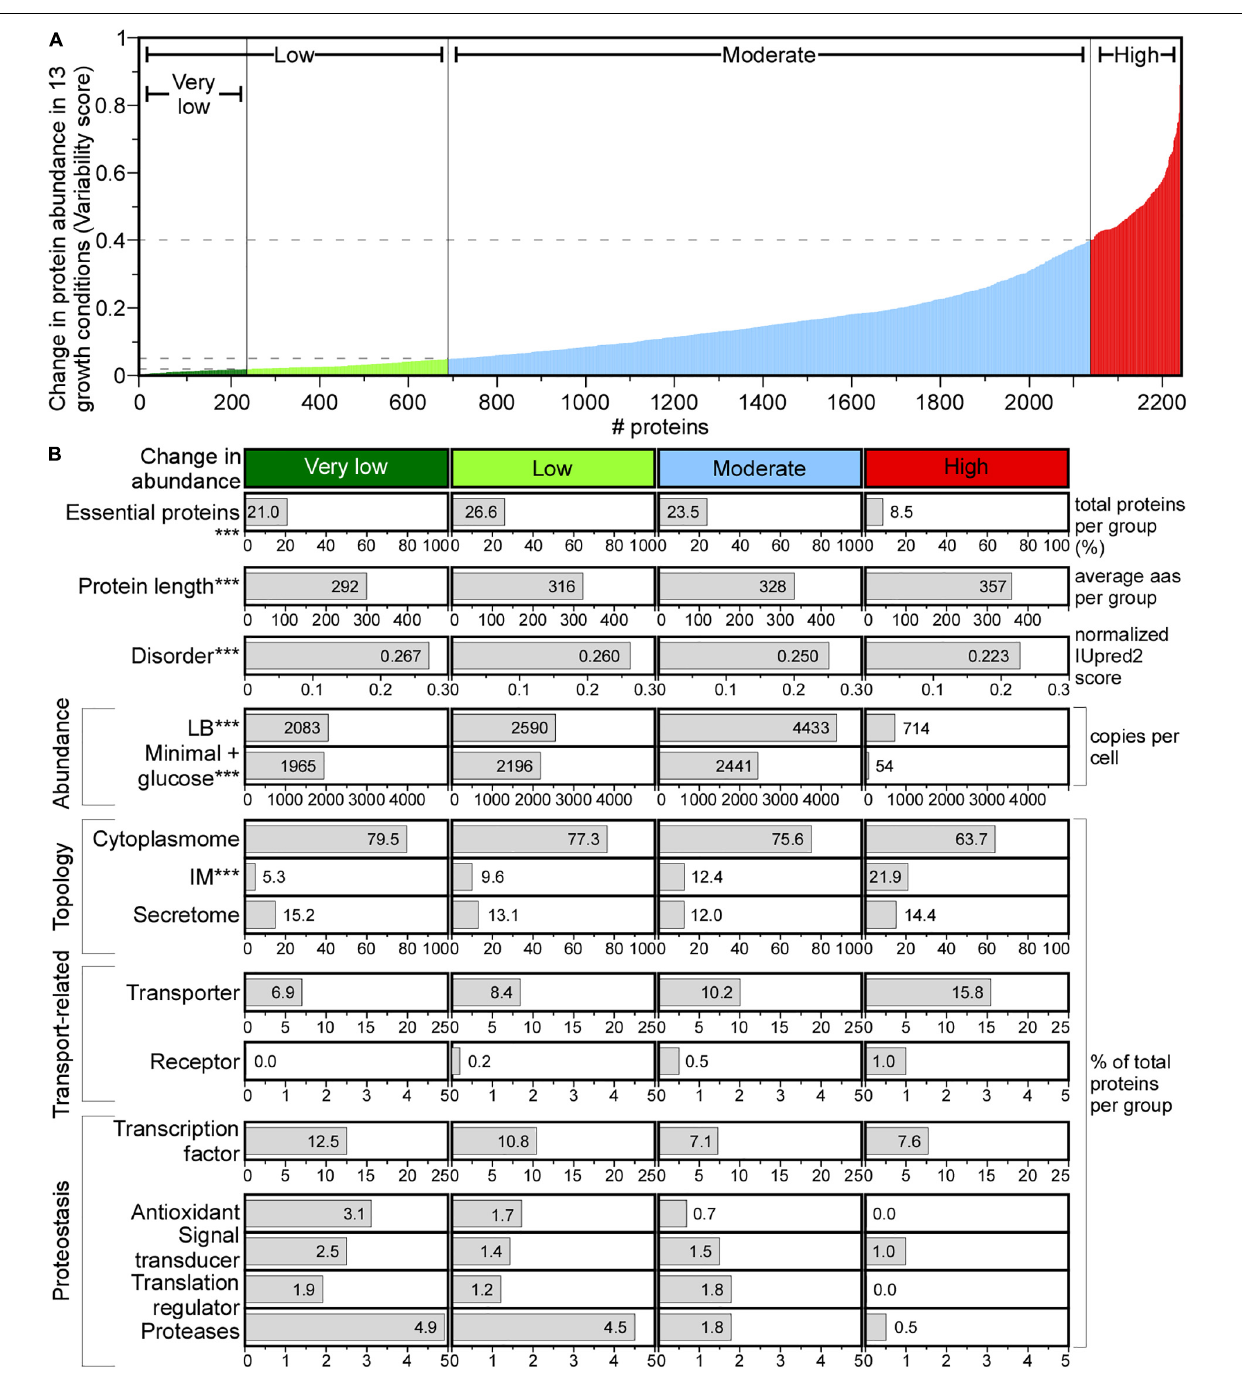
FIGURE 6 | Change in protein abundance across different media. (A) Change in protein abundance plotted using variability score (see section “Materials and Methods”) for each protein. Proteins were classified in the indicated groups. (B) Protein features quantified for each group. Statistical analysis was done using Kruskal–Wallis Test or Fisher’s exact test: ∗ p < 0.05; ∗∗ p < 0.01; ∗∗∗ p < 0.001 for the comparison between very low and high score groups. aas, amino